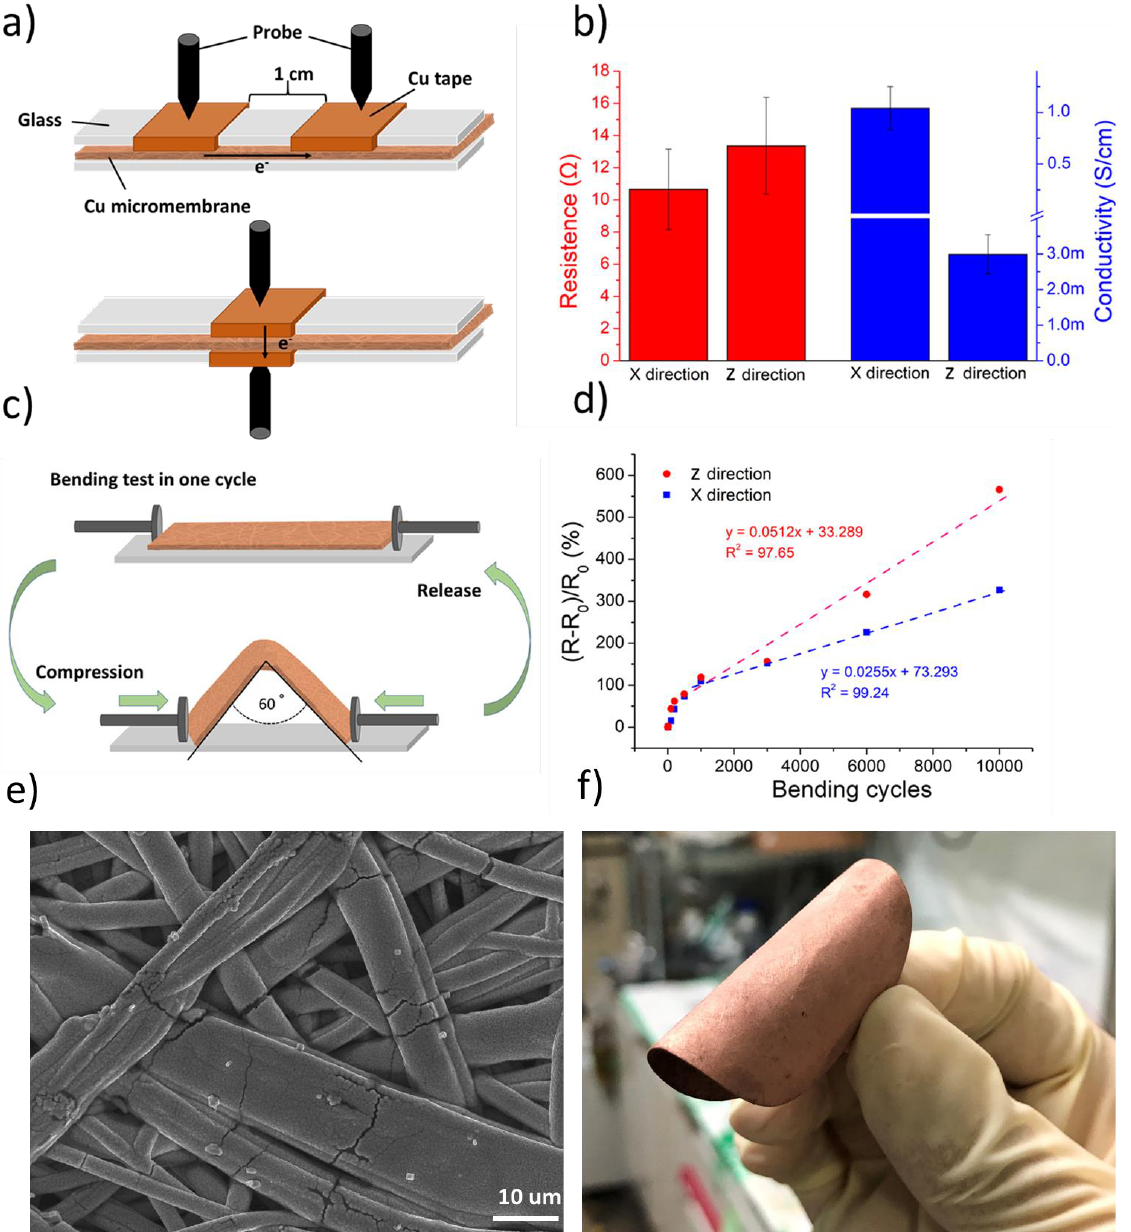
Figure 8. ( a ) The schematic of measurement setup for electrical resistance in both X and Z directions. ( b ) The bar chart for electrical resistance and conductivity in both X and Z directions. ( c ) The schematic of measurement setup for bending test. ( d ) The variation in percentage for electrical resistance as a function of bending cycles. ( e ) The top-view SEM images of Cu micromembrane after bending test. ( f ) A photograph showing the flexible nature of Cu micromembrane.